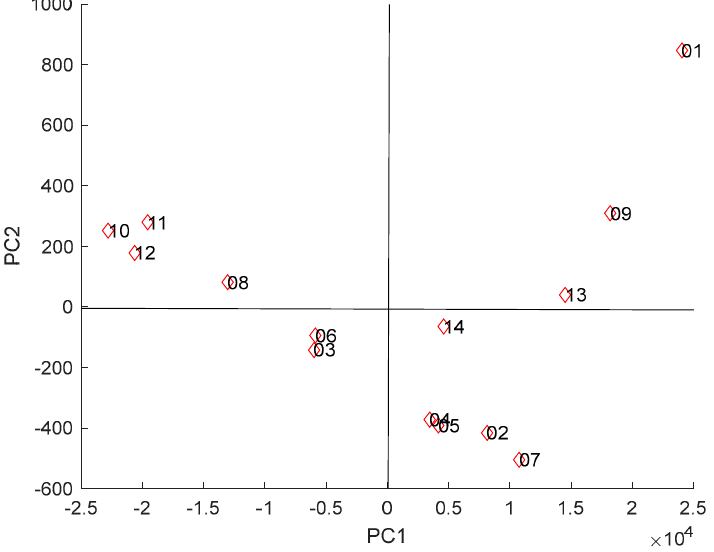
Figure 3. Principal coordinates analysis (PCO) plot of the fourteen